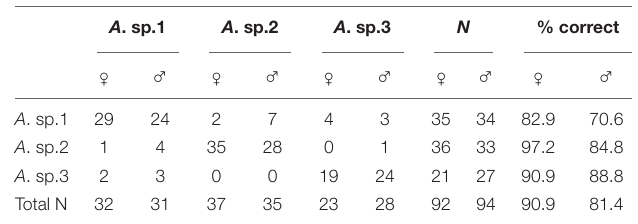
TABLE 4 | Classification matrix for leave-one-out cross validation of individuals of the Brazilian species based on